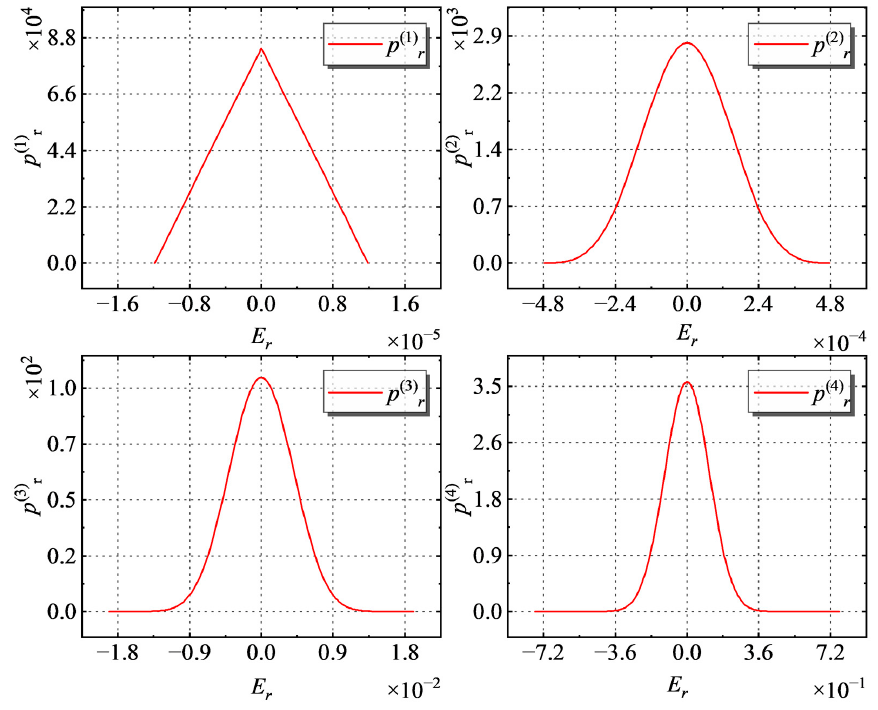
( n ) r on E r on E r . r